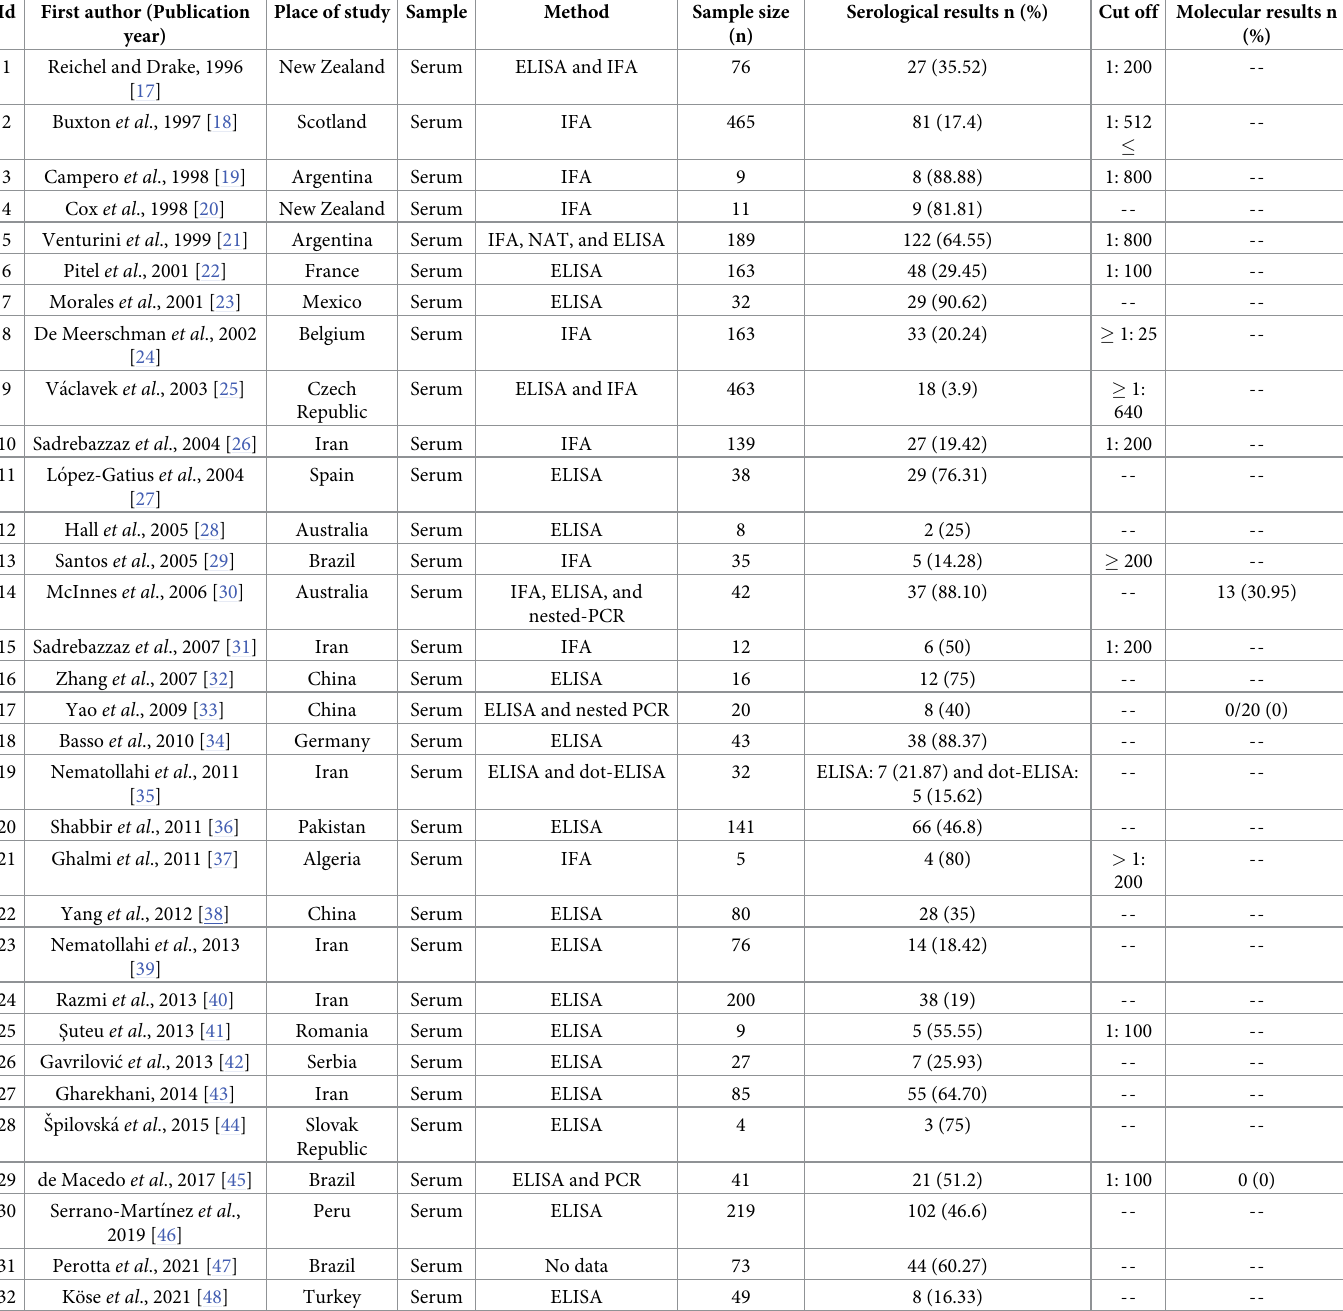
Table 1. Description of the studies included the prevalence of N . caninum in bovines that had an